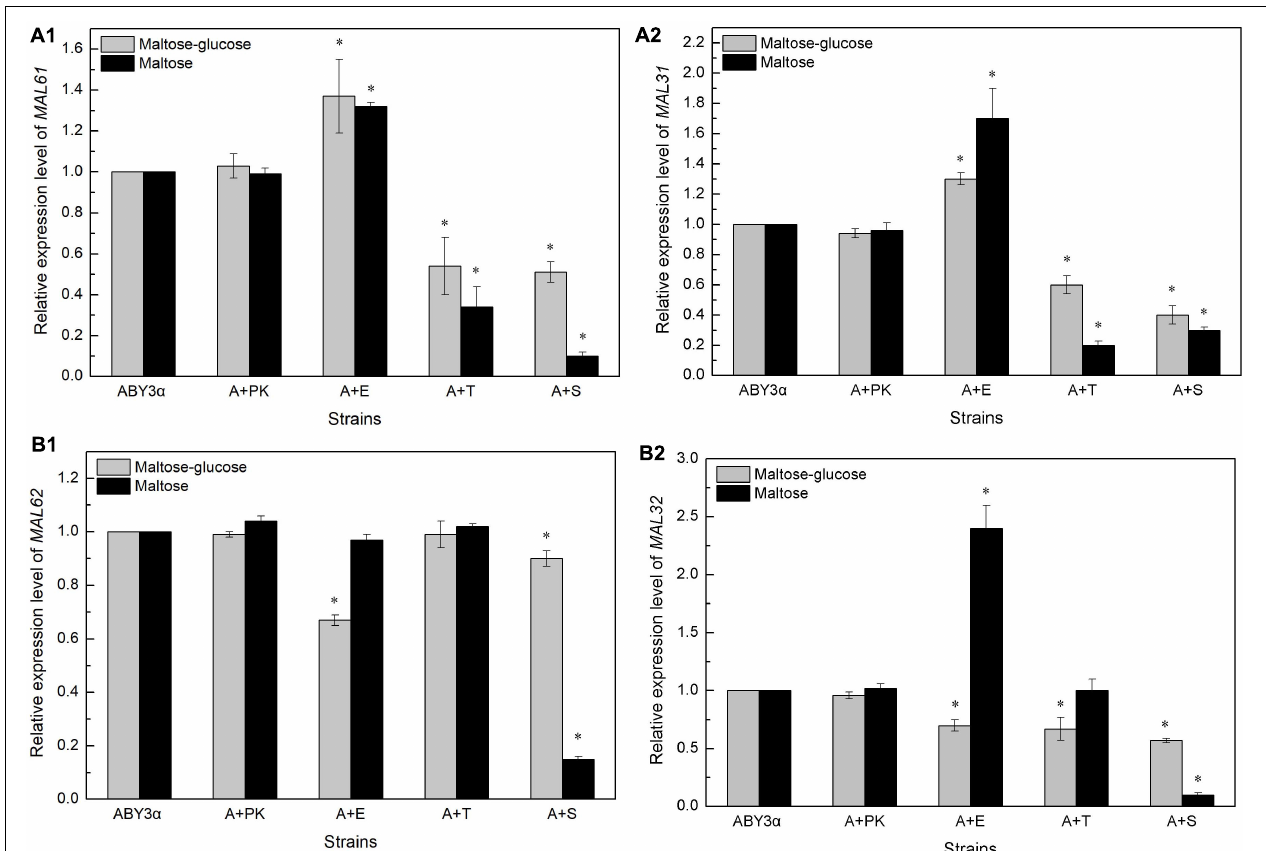
FIGURE 5 | Expression levels of (A) MALx1 and (B) MALx2 in the single-kinase gene overexpression. 2 g fresh yeast was cultured in the LSMLD media and cultures were sampled at 30 min. The expression levels of genes (A1) MAL61 , (A2) MAL31 and (B1) MAL62 , (B2) MAL32 were tested using qRT-PCR. ABY3 α , the parental strain; A+PK, the strain carrying the vector Yep-PK used as a blank control to demonstrate any possible effect of the empty vector; A+E, the transformant carrying ELM1 overexpression; A+T, the transformant carrying TOS3 overexpression; A+S, the transformant carrying SAK1 overexpression. Significant differences of the transformants to the parental strain were confirmed at ∗ P <